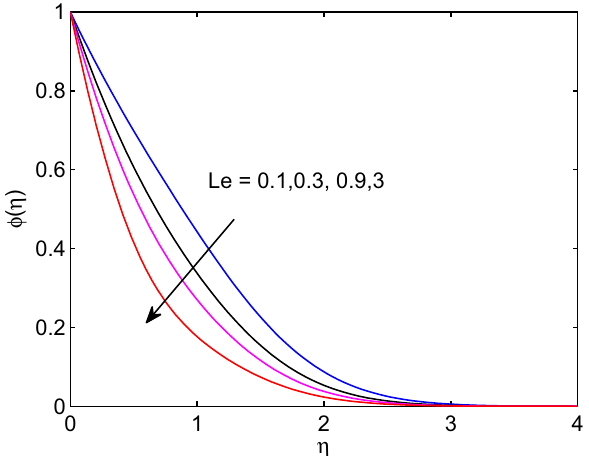
Figure 20. Lewis number effects on volumetric concentration profiles.